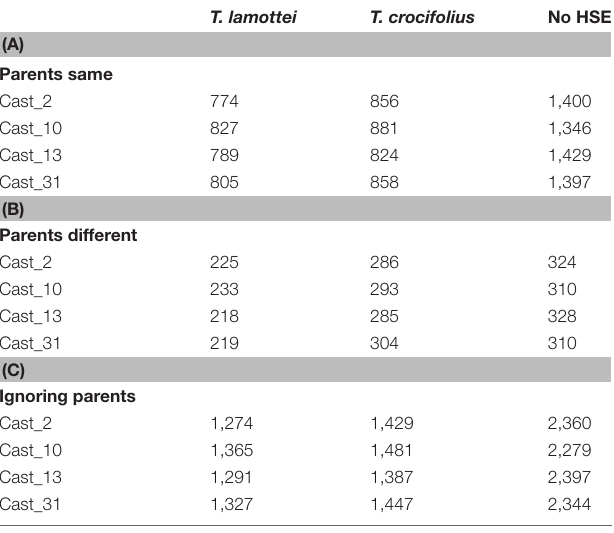
FIGURE 4 | Homoeolog-specific expression overlap across T. castellanus . Set IDs represent samples where parents are different (PD) or the same (PS) and the direction of homoeolog-specific expression (i.e. toward higher expression of the T. lamottei (Lam) or T. crocifolius (Croc) homoeolog). Overlapping sets are indicated by filled circles, and the number of loci within that intersection may be seen directly above in the bar chart with corresponding size over each bar. The total sample sizes are found in the left bar chart and correspond to the adjacent